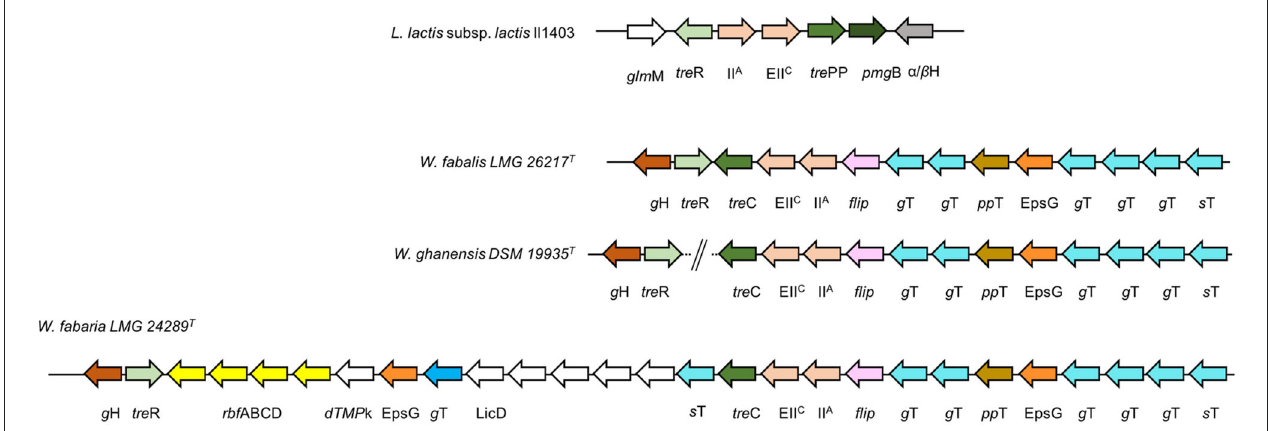
FIGURE 6 | Trehalose operon in Weissella species. Genomic organization of the putative trehalose operon in the Weissella species. Gene clustering is represented by the arrows superposed on the black horizontal line. Gene and intergenic spaces are not drawn in scale. Lactococcus lactis subsp. lactis Il1403 (GenBank accession no. NC_002662): glm M, phosphoglucosamine mutase; tre R, trehalose operon repressor; IIA, PTS glucose transporter subunit IIA; EIIc, PTS transporter subunit EIIC; pmg B, beta-phosphoglucomutase; α / β H, alpha/beta hydrolase; gH, glycosyl-hydrolase; polysaccharide biosynthesis C-terminal domain-containing protein flip, flippase; g T, glycosyltransferase; pp T, polysaccharide pyruvyl transferase family protein; EpsG, EpsG family protein; s T, sugar transferase; rbf ABCD, rhamnose operon; dTMPk, dTMP kinase, LicD, LicD family protein.